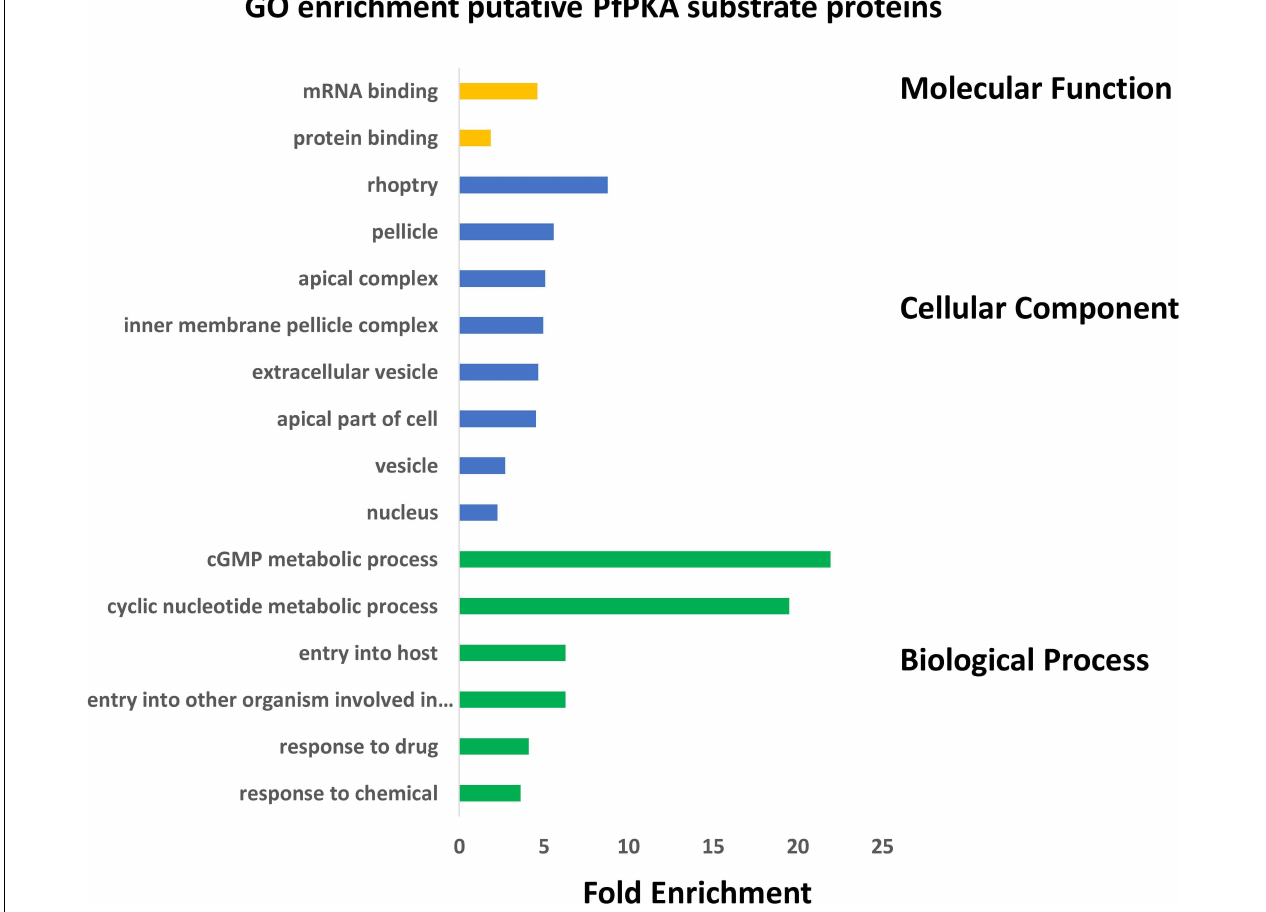
FIGURE 3 | Gene Ontology (GO) enrichment analysis of 109 putative PfPKA substrate proteins. GO enrichment analysis of proposed PfPKA substrates from Supplementary Table 4 was performed with the GO enrichment analysis tool of PlasmoDB (https://plasmodb.org/plasmo/app), and the results are depicted in a histogram for terms with p adjusted (Benjamini-Hochberg) < 0.05. Terms excluded from the histogram are those with less than three PfPKA substrates, as well as very broad terms with more than 2,000 proteins in the Plasmodium falciparum proteome.